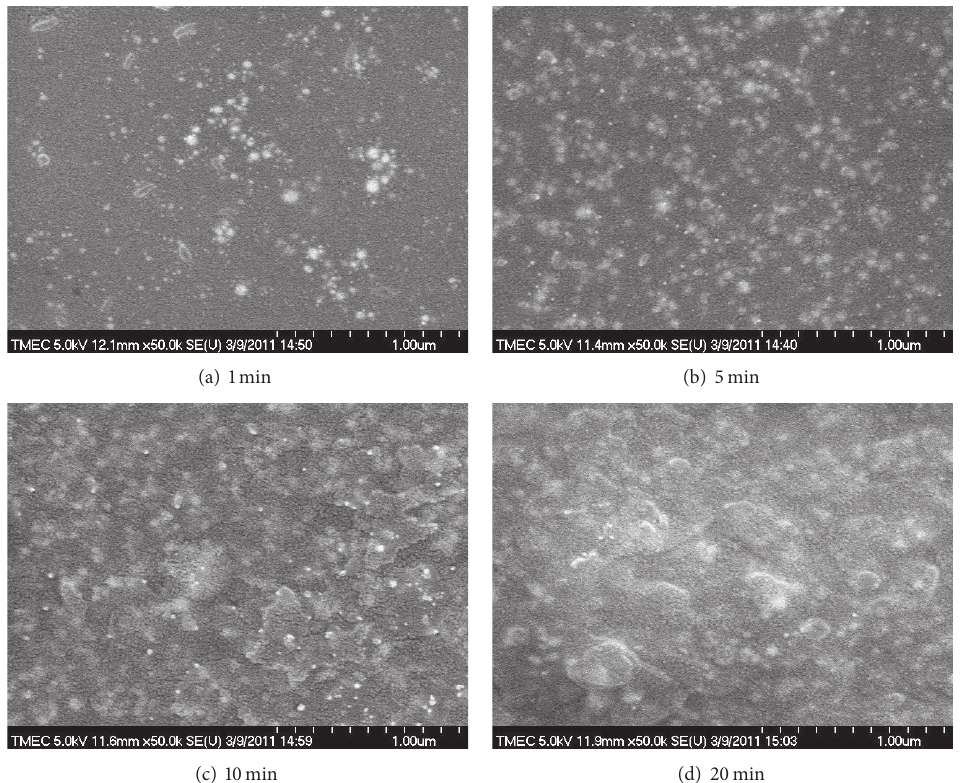
Figure 3: SEM images of Ag NPs film at various deposition times of (a) 1min, (b) 5min, (c) 10min, and (d) 20min.